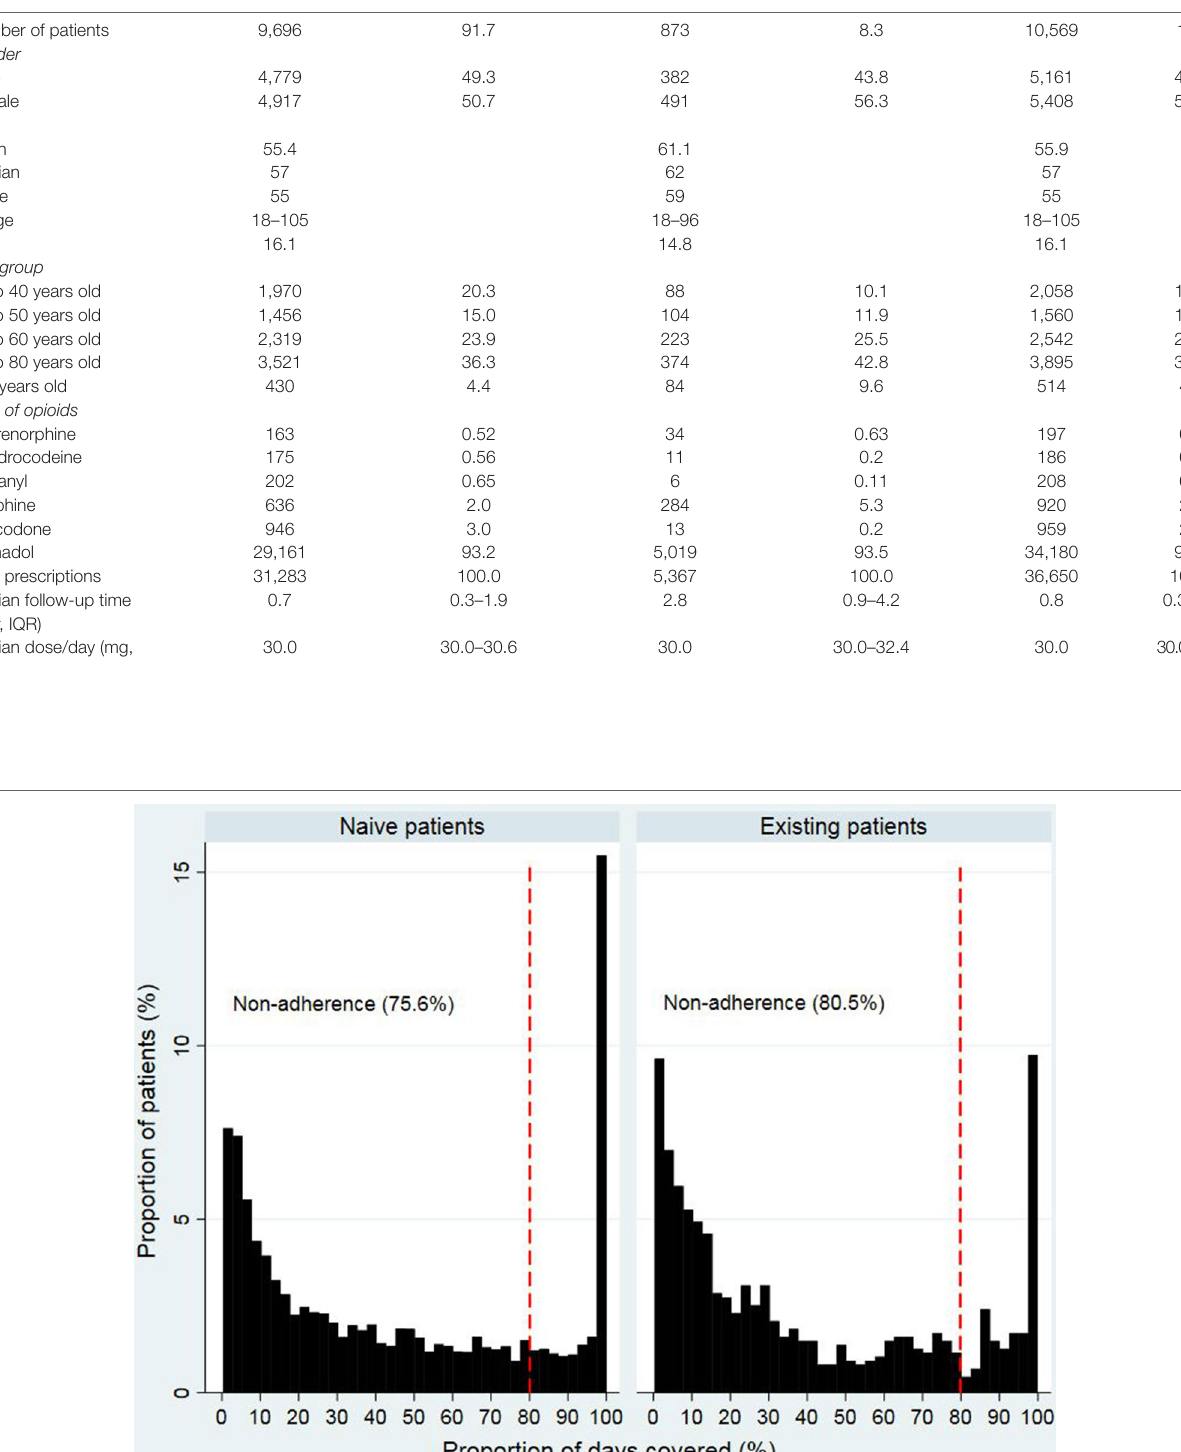
Frontiers in Pharmacology |